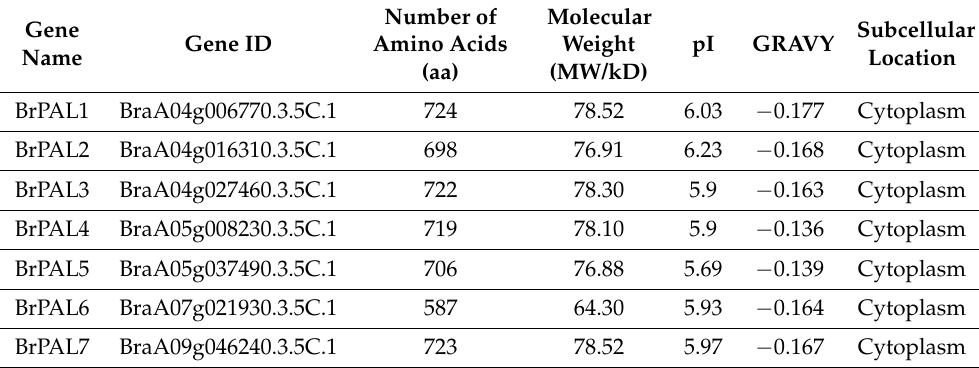
Table 1. Sequence characteristics of BrPAL .